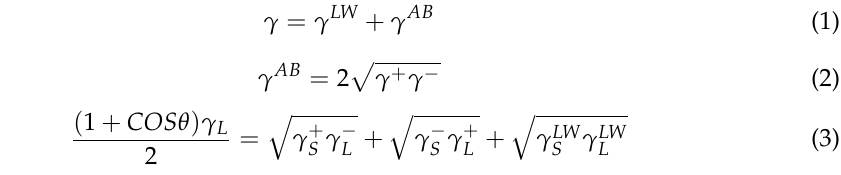
Table 3. Surface free-energy parameters of chemical droplets and aggregate.